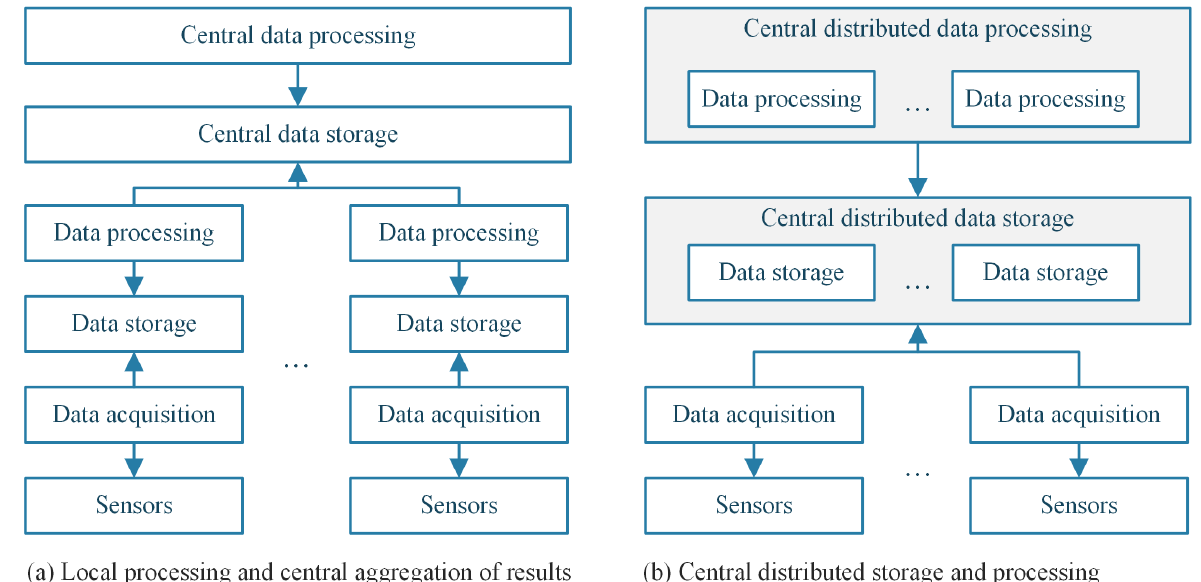
Figure 1. Two architectures for processing sensor data. ( a ) The sensor acquisition, storage and processing are performed locally, and the processed results are sent to the central data storage component, which is accessed by the central data-processing component for further data analysis. ( b ) The components that perform the data acquisition store the information in central distributed data storage, which is accessed by distributed data-processing